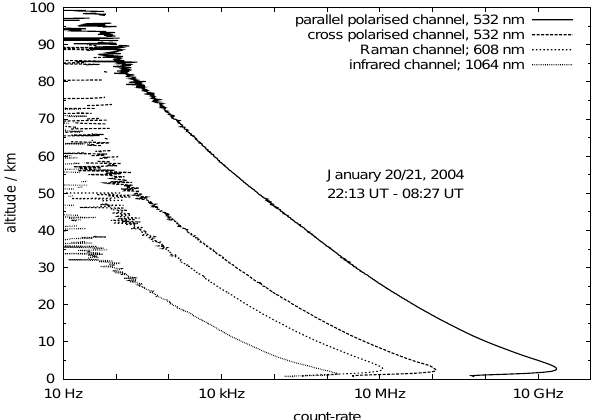
Fig. 5. Lidar raw data from 20/21 January 2004 in 2- λ configu- ration. Shown are data of parallel polarised and the cross polarised channel at 532-nm wavelength, data of the vibrational-Raman chan- nel at 608-nm and of the infrared channel at 1064-nm wavelength. The cascaded green channels are fitted to the most intensive in each polarisation and afterwards merged. Thus, high count rates of 10GHz and more can be